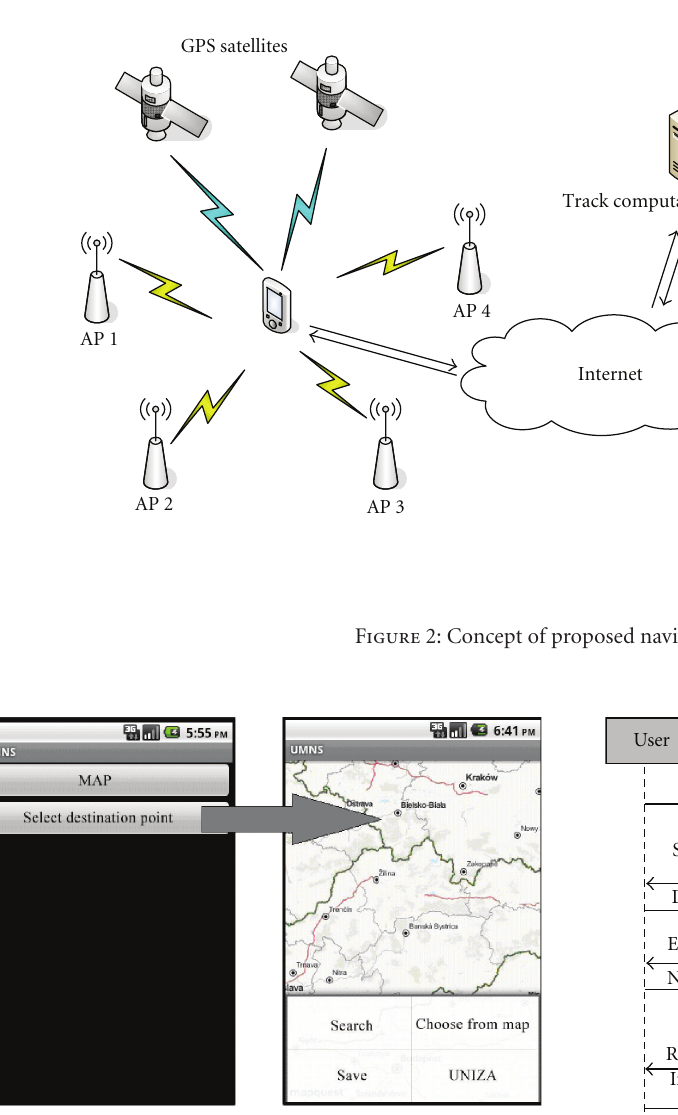
Figure 3: Menu to choose destination point of navigation.